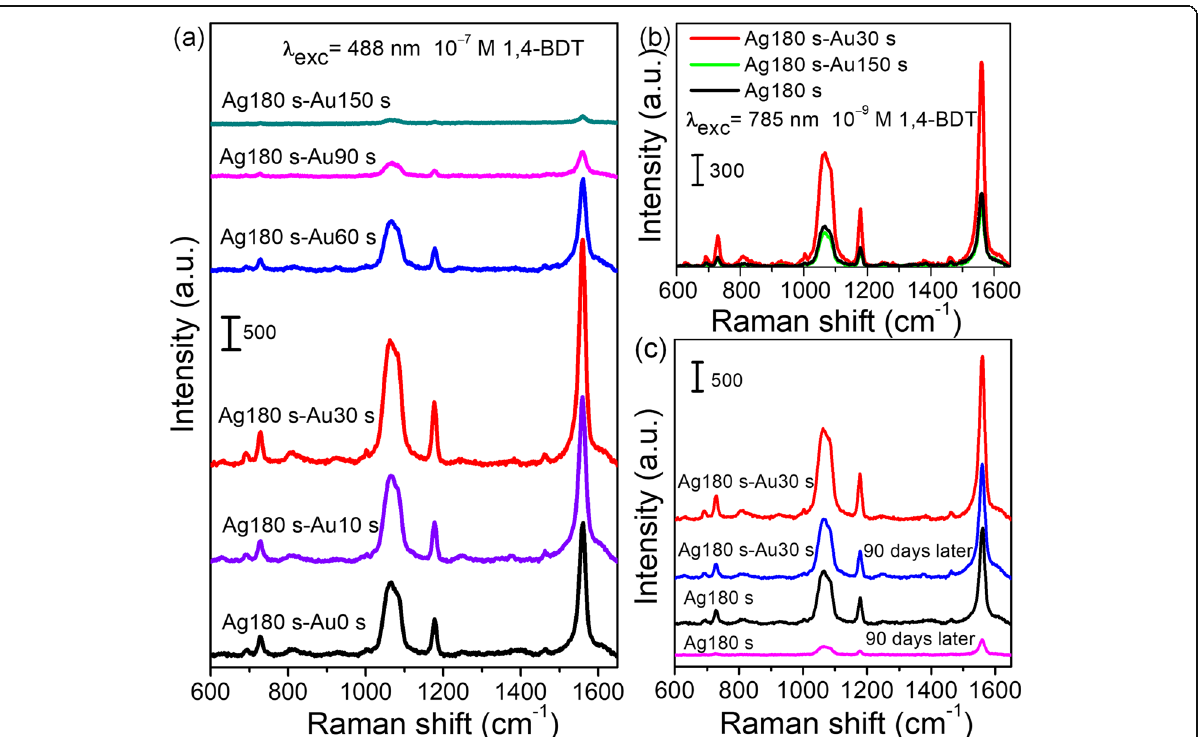
Fig. 4 a , b SERS spectra of 10 − 9 M 1,4-BDT adsorbed on dendritic Ag nanostructures and Au/Ag bimetallic nanostructures excited at 488 nm and 785 nm, respectively. c SERS spectra of 10 − 9 M 1,4-BDT detected at the freshly prepared and 90-day-old substrates, respectively. Curves are shifted vertically for clear